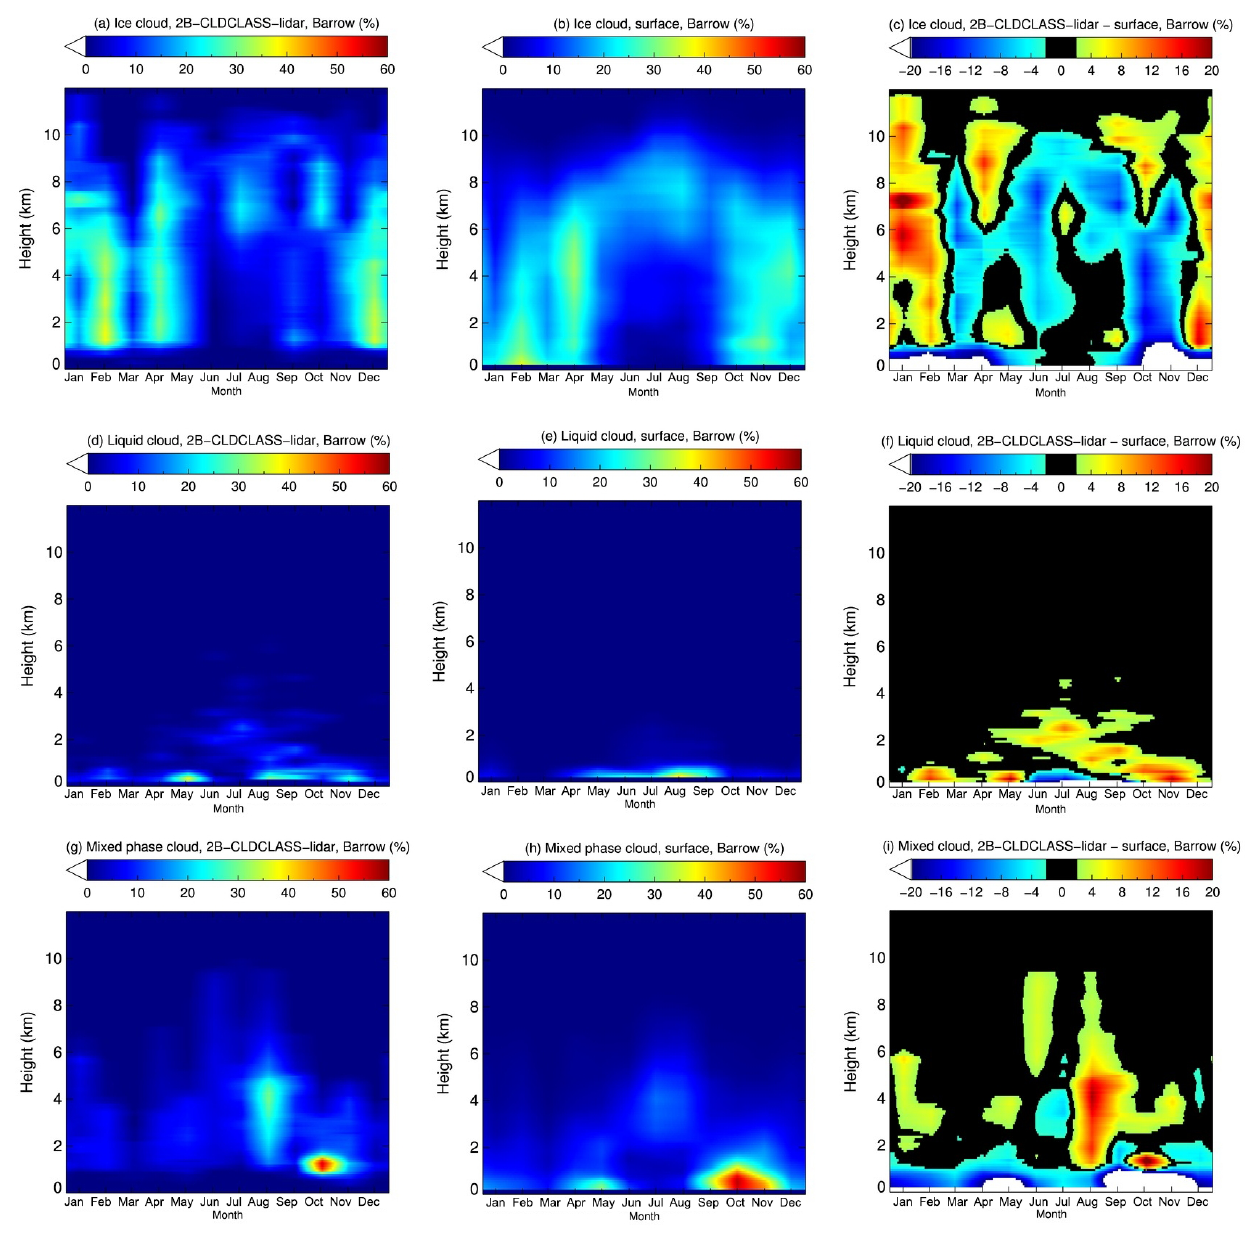
Figure 7. Vertical distributions of ice phase clouds (a–c) , liquid phase clouds (d–f) , and mixed-phase clouds (g–i) from 2B-CLDCLASS- lidar (a, d, g) , from surface observations (b, e, h) , and the difference of 2B-CLDCLASS-lidar and surface observations at Barrow for